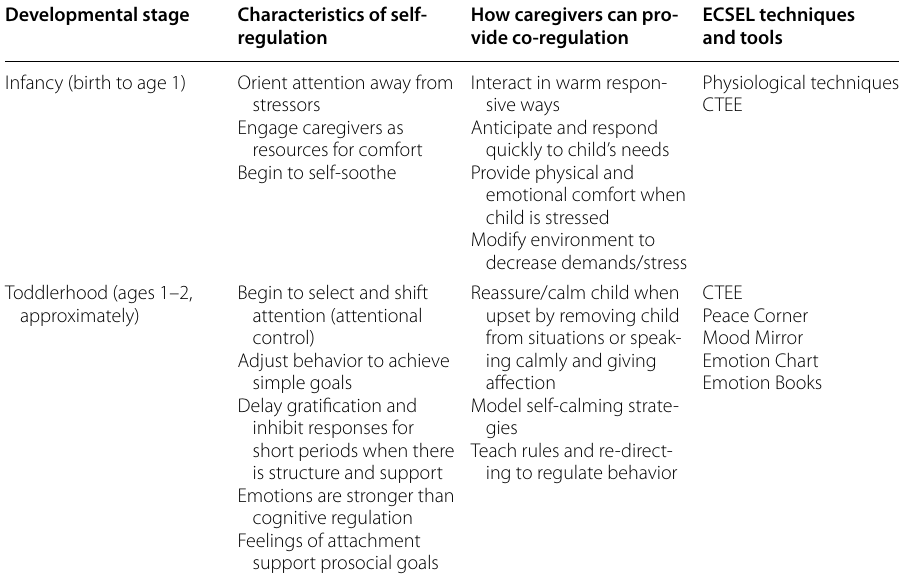
Table 1 Promoting the growth of self‑regulation development and co‑regulation from birth through age 2: ECSEL approach. Adapted from Murray et al. (2016b) Developmental stage